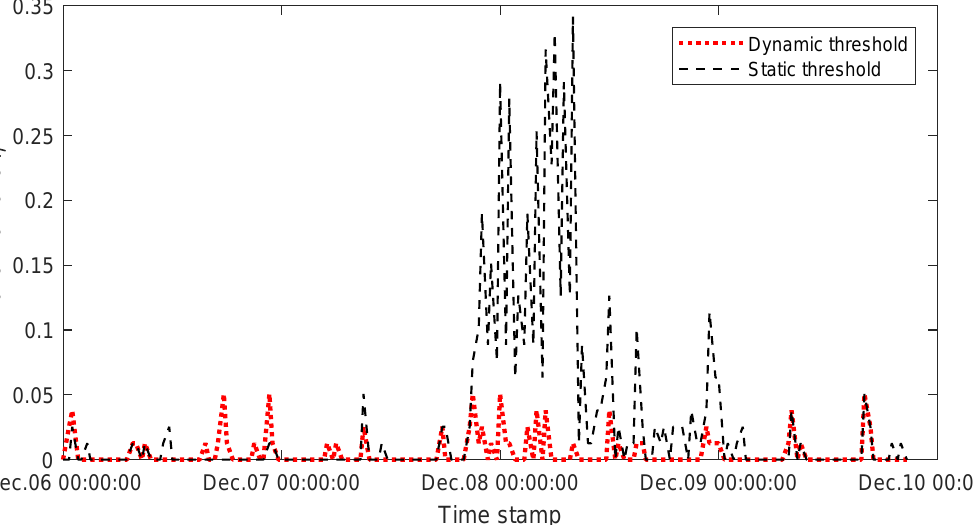
Figure 13. Comparative results of abnormal ratio results of the validation residuals under dynamic thresholds and static